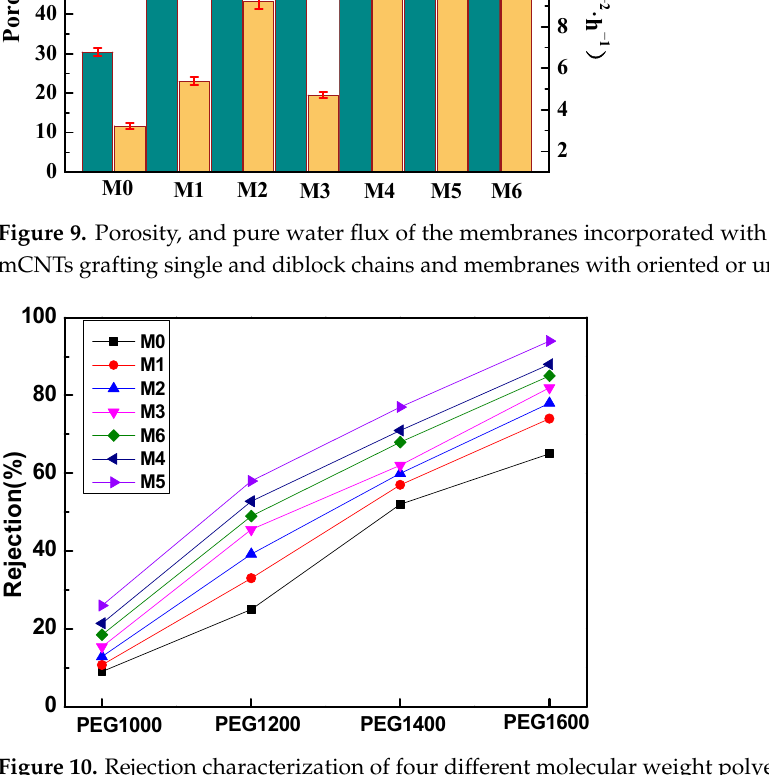
Figure 10. Rejection characterization of four different molecular weight polyethylene glycol (PEG) with different membrane samples.